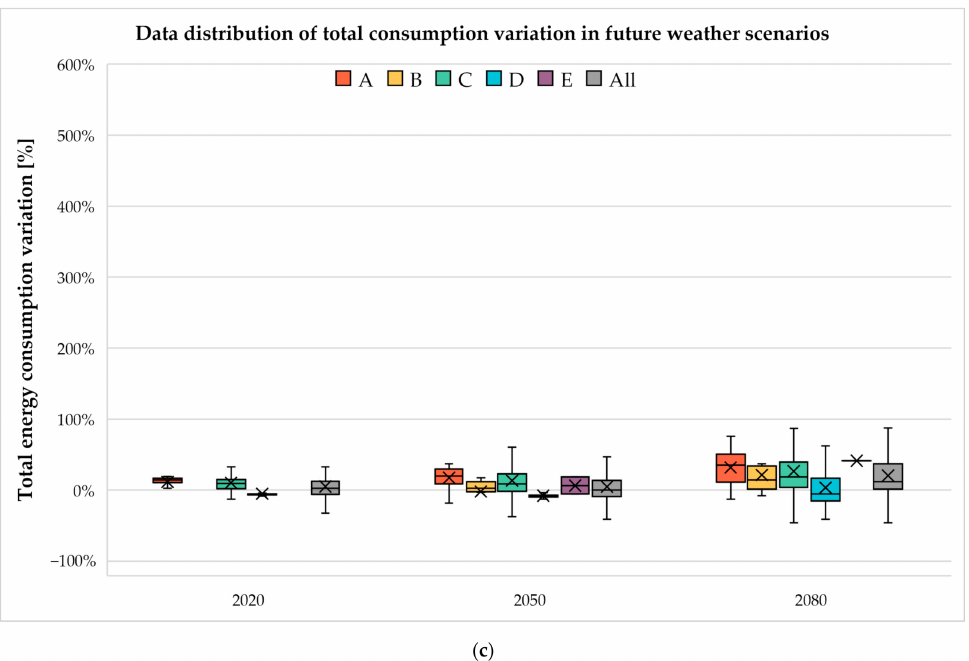
Figure 3. ( a ) Data distribution of heating consumption variation divided by climate zones (zones A, B, C, D, E, and overall zones) and by future time slices. The marker “x” indicates the mean values, whilst the market “-” indicates the median values. ( b ) Data distribution of cooling consumption variation divided by climate zones (zones A, B, C, D, E, and overall zones) and by future time slices. The marker “x” indicates the mean values, whilst the market “-” indicates the median values. ( c ) Data distribution of total consumption variation divided by climate zones (zones A, B, C, D, E, and overall zones) and by future time slices. The marker “x” indicates the mean values, whilst the market “-” indicates the median